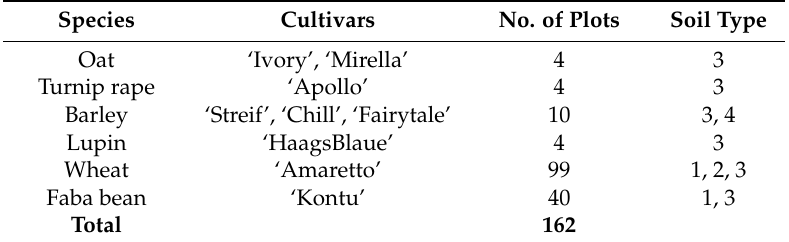
Table 1. Field plots measured in the study. Soil types: fertile luvic stagnosol and sandy clay loam (1), haplic gleysols and silty clay loam (2), sulfic cryaquepts (3), fertile luvic stagnosol and sandy medium clay loam (4) (WRB,